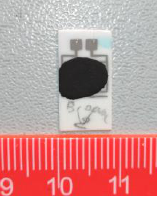
Figure 1. Image of a biochar sensor prepared by drop coating technique.